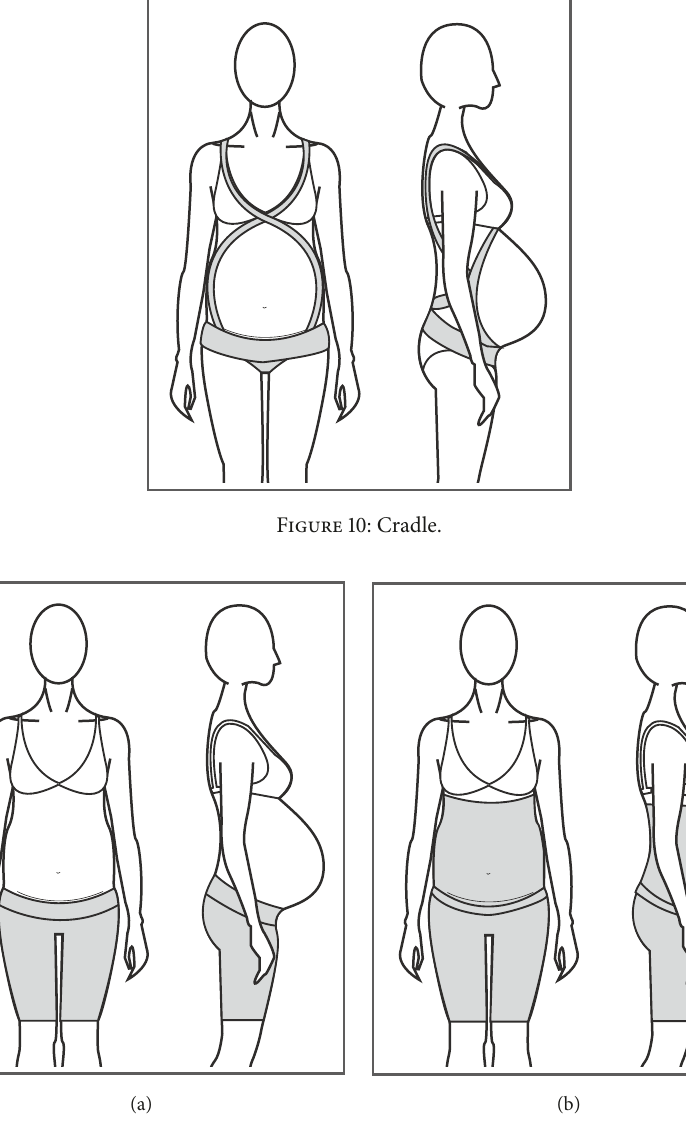
Figure 11: (a) Short with abdominal support. (b) Short with belly